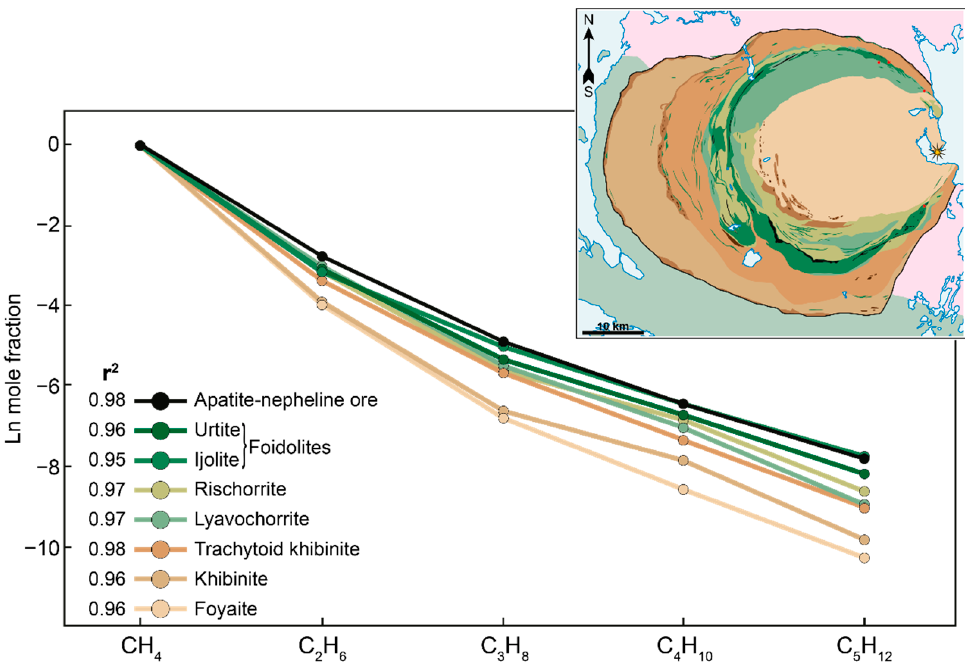
Figure 3. Median molecular weight distributions of hydrocarbon gases in the magmatic rocks and apatite–nepheline ore of the Khibiny massif. r 2 —coefficients of determination to best ‐ fit lines. The top right shows the geological scheme of the Khibiny massif (see also Figure 1). The colors of the lines on the graphs correspond to the colors of the rocks on the geological scheme of the massif for easier comparison.